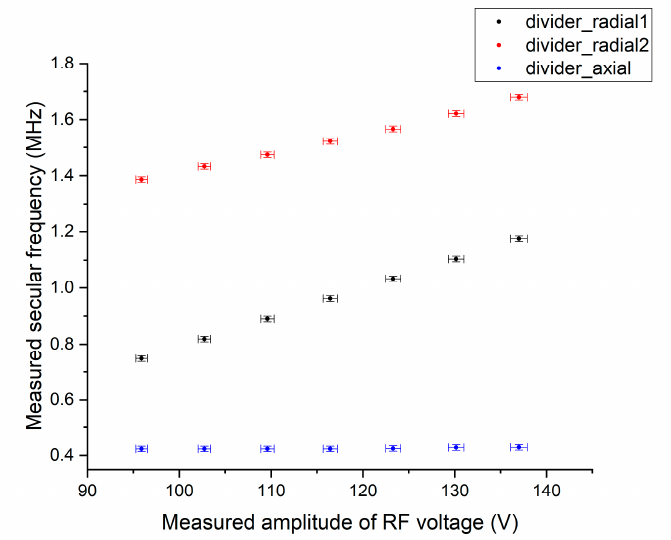
Figure 10. Relation between measured secular frequencies and RF voltage amplitude measured by the proposed voltage divider. The uncertainty of the measured RF voltage amplitude is 0.659% .